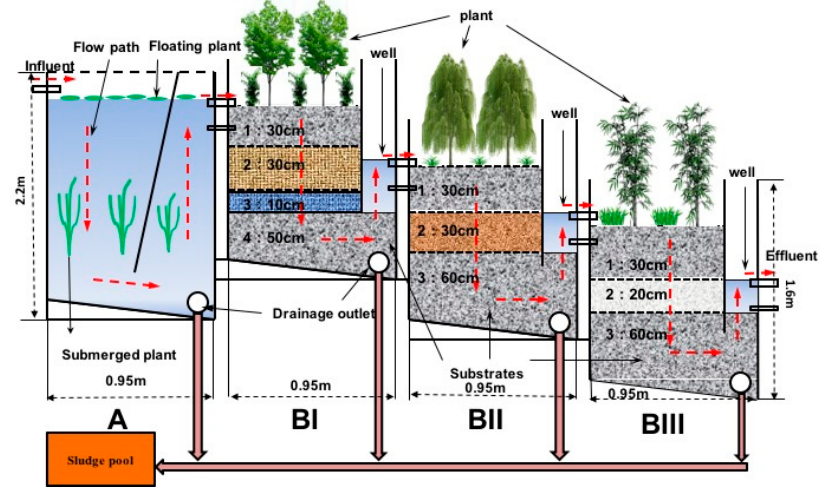
Figure 1. Constructed wetland system designed for treatment of rural household sewage (Layer numbers in BI, BII and BIII correspond to the numbers of substrate layers in Table